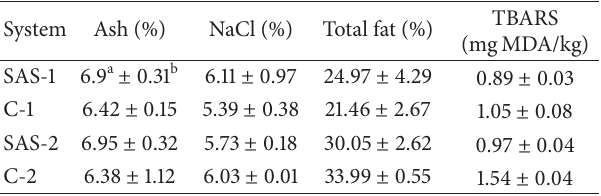
Table 2: Ash and NaCl concentration, total fat content, and TBARS values registered for dry sausages at the end of the ripening period.